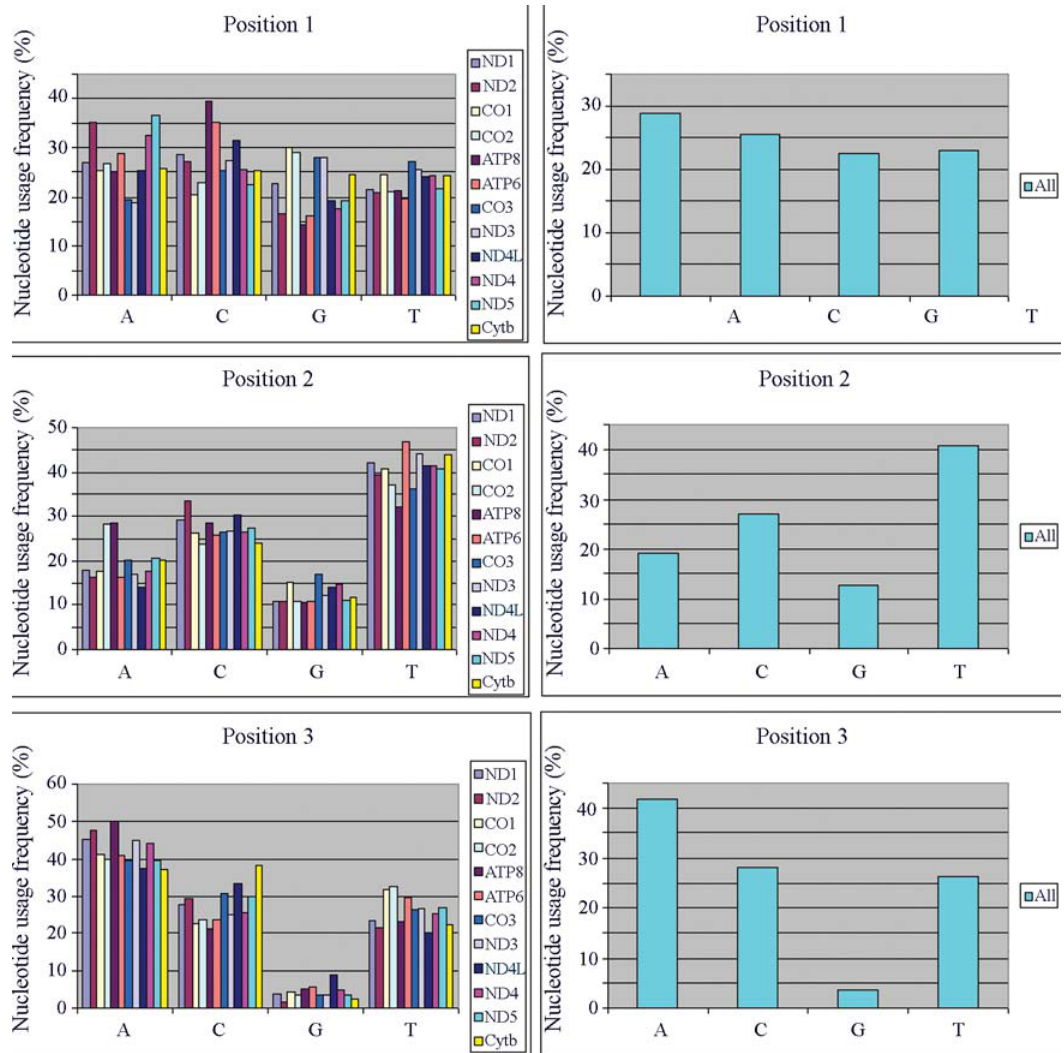
Figure 3 - Nucleotide composition of the 12 mitochondrial genes coded on the heavy strand. Nucleotide composition at first, second and third positions for individual genes is presented on the left side. On the right side, averages across all genes are